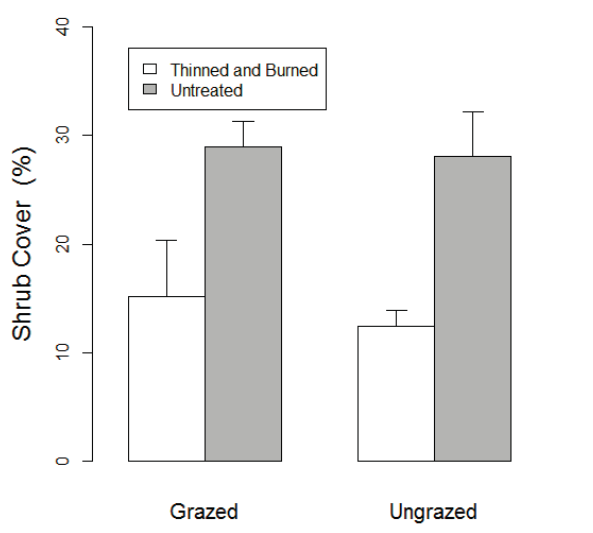
Figure 8. Mean values of field measured shrub cover in grazed and ungrazed plots that were either thinned and burned or untreated. Standard error bars are